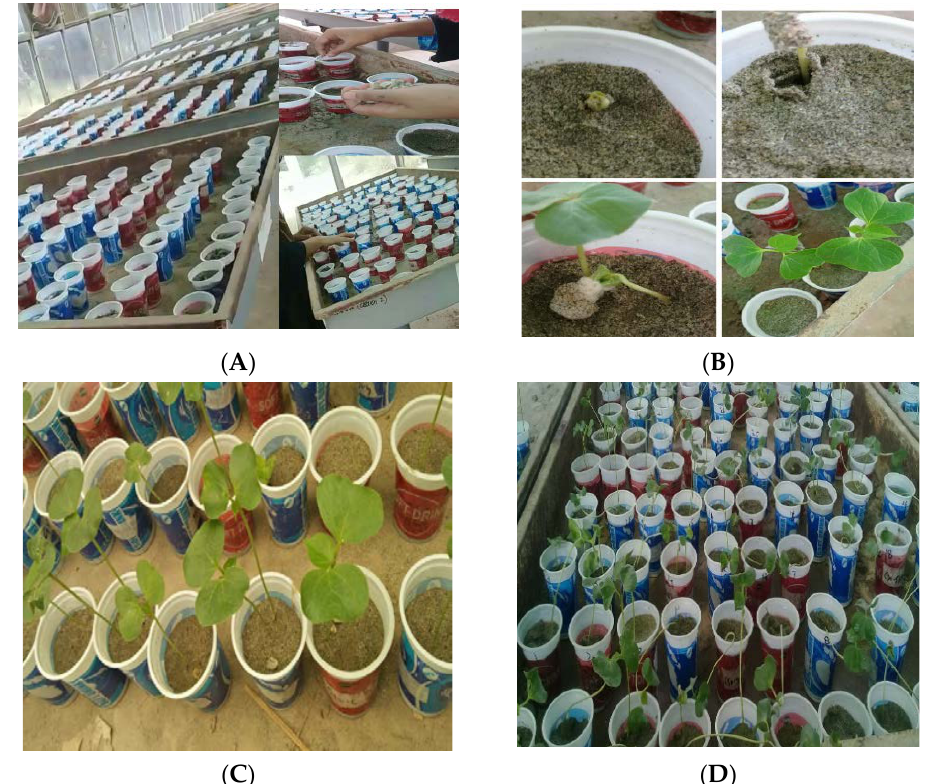
Figure 1. Visual representation of seedling emergence of cotton genotypes under greenhouse conditions: ( A ) Seed planting in sand pots; ( B ) Leaves emergence from cot- yledon; ( C ) Emergence of true leaves; ( D ) General shot of the pots before the drought stress.